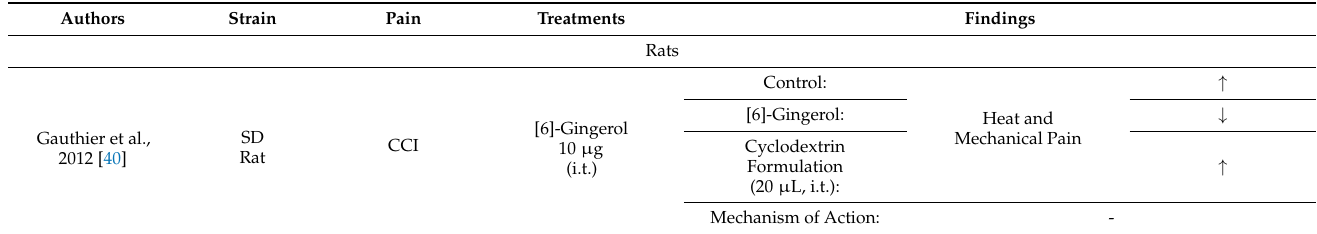
Table 2. Summary on the effect of [6]-gingerol and [6]-shogaol on